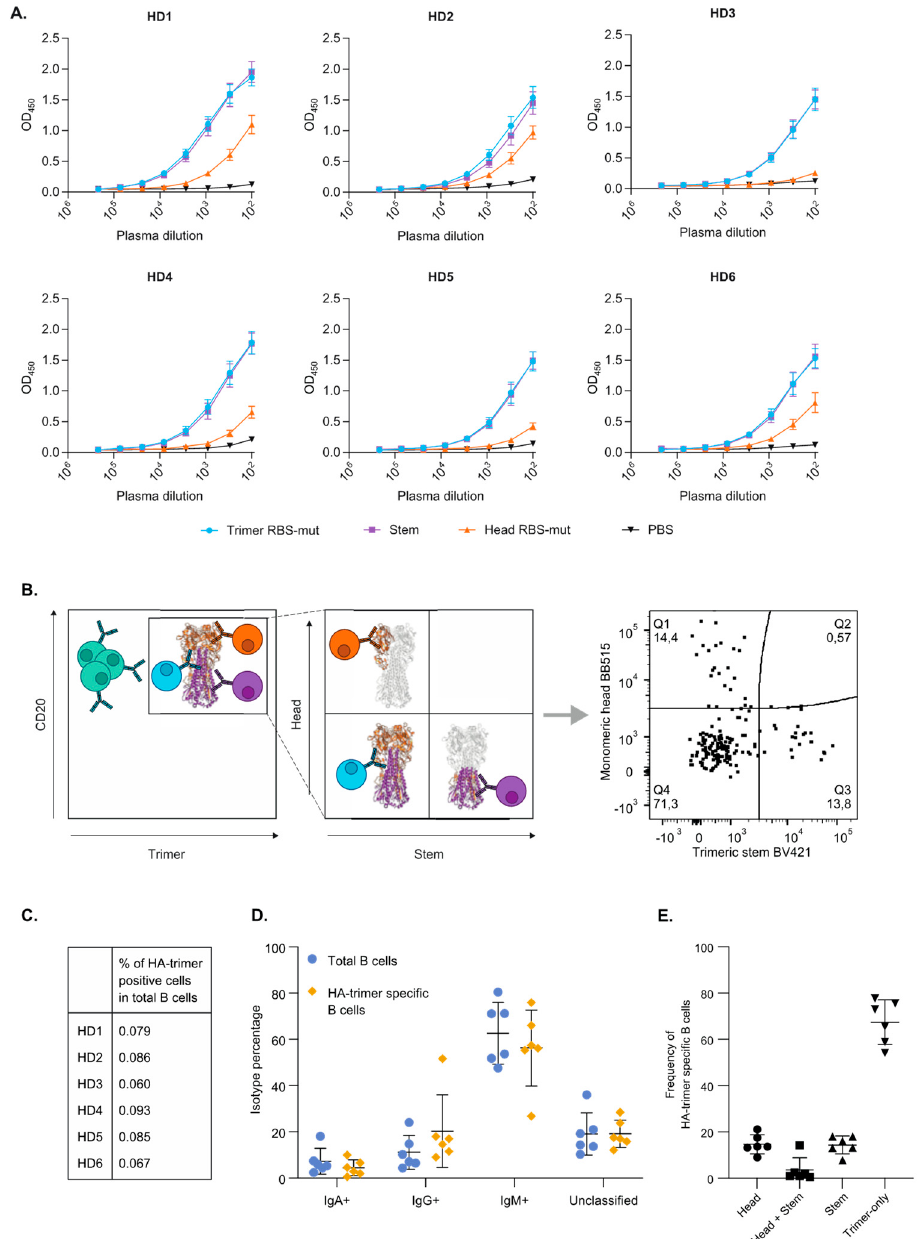
Figure 2. Binding domains and isotypes of HA-trimer H1N1 pdm2009 specific B cells. The antibody responses of six healthy donors were evaluated on antibody level by ELISA and on B cell level by flow cytometry. ( A ) The IgG antibody responses in plasma of six healthy donors (HD) to HA-trimer RBS-mut (blue), trimeric stem (purple), or monomeric head RBS-mut (orange) were measured in a Strep-Tactin XT ELISA. ( B ) A schematic representation of the triple-probe flow cytometry strategy used in this study. The HA-trimer specific cells (CD20+/HA-trimer+) are depicted in the left panel together with HA-negative B cells (in green). The HA-trimer specific population was analyzed as shown in the right panel together with representative flow cytometry plot, with monomeric head+ cells (orange), trimeric stem+ cells (purple) and the cells that are not recognizing the head or stem probe (blue). ( C ) Frequencies of HA-trimer specific B cells among total B cells in six healthy donors. ( D ) Frequencies of IgA, IgM and IgG positive B cells among total B cells (blue) and HA-trimer specific B cells (yellow). B cells that were double/triple positive or negative for all three isotypes were unclassified. ( E ) Frequencies of probe positive cells among the population of HA-trimer specific B cells.